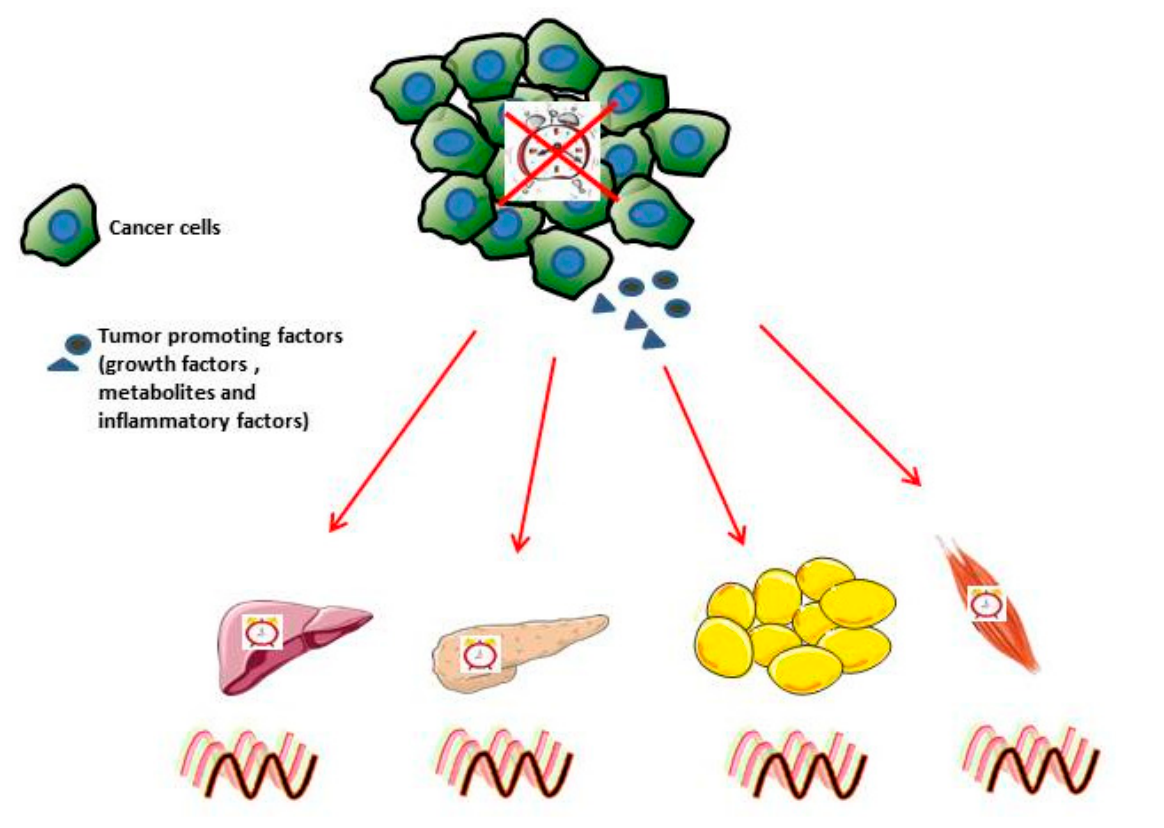
Figure 2. Cancer affects peripheral clock rhythms. Cancerous cells have disrupted circadian rhythms that promote excessive generation of tumor-promoting factors. These tumor-promoting factors, i.e., growth factors such as Transforming growth factor β (TGF β ), and fibroblast growth factor (FGF); inflammatory factors, chemokines and cytokines; metabolic waste byproduct such as lactate are secreted into the blood and travel to the nearby healthy peripheral tissues such as liver, pancreas, adipose tissue and muscle resultingin disturbed rhythmicity in peripheral clocks and its downstream pathways. Table 1. Clock gene expression in animal models of different cancer types.